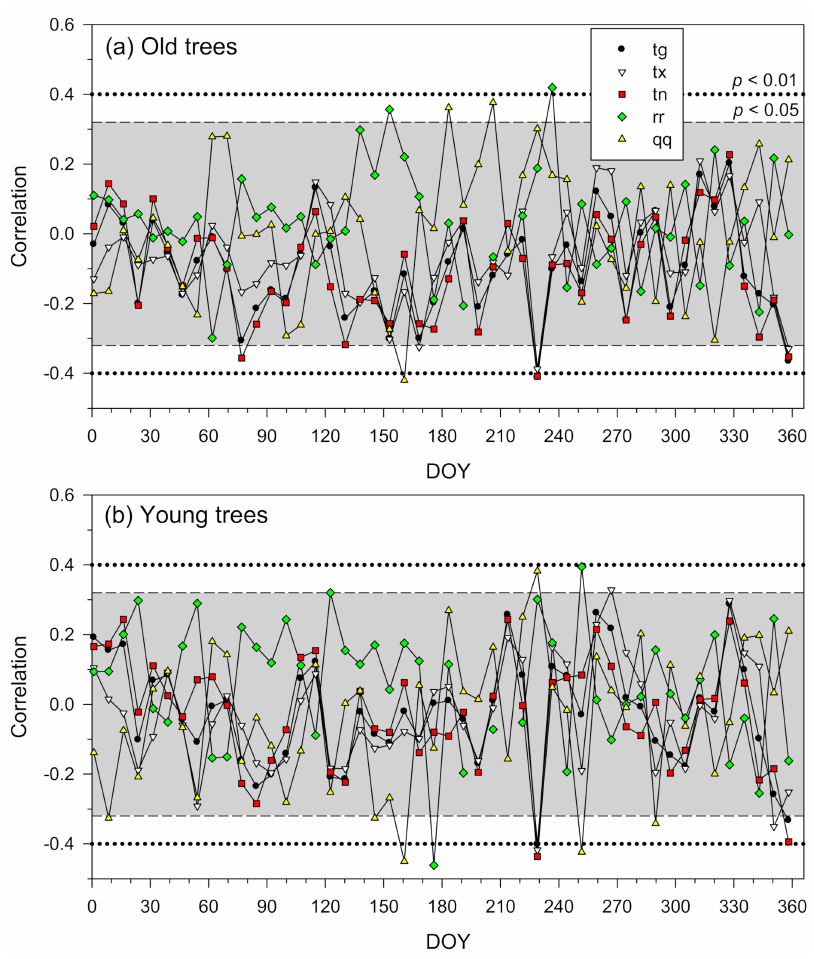
Figure 4. Correlations between the ring width indices of old ( a ) and young ( b ) trees and weekly climate variables (tg, mean temperature; tx, mean maximum temperature; tn, mean minimum temperature; rr, precipitation and qq, radiation) calculated at the weekly scale. The x-axis indicates the day of the year (DOY). Horizontal dashed and dotted lines show the 0.05 and 0.01 significance levels, respectively. Significant values are those located outside the grey